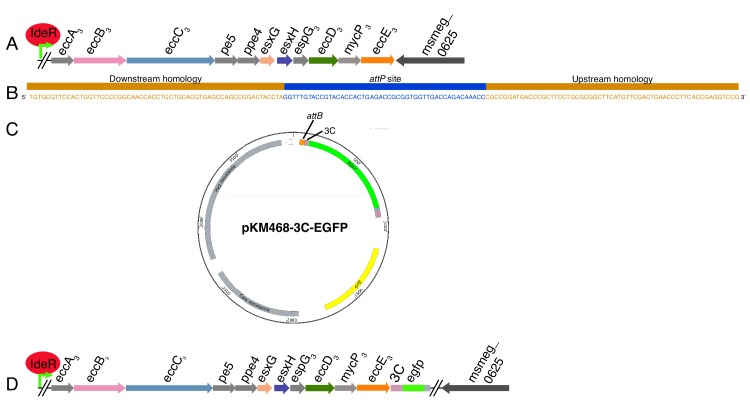
ORBIT tagging of the chromosomal copy of EccE3.(A) Diagram of the ESX-3 operon in M. smegmatis mc(2)155. (B) The targeting oligo used to insert the attP site into the chromosome. (C) The tagging plasmid.(D) Cartoon of the resulting change to the chromosome after ORBIT.